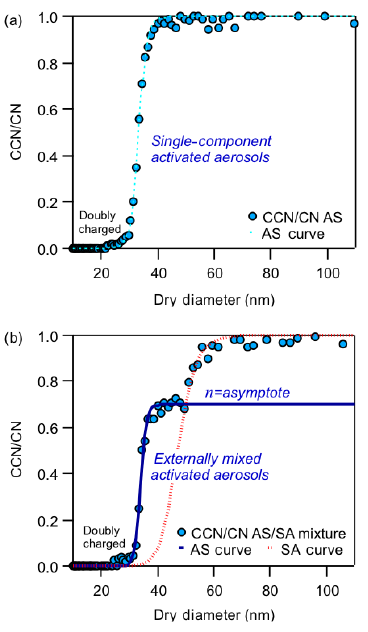
Figure 2. Example of a charge-corrected (a) single-component ac- tivation curve and (b) a multiple activation curve from an externally mixed/heterogeneous system. The asymptote, η , varies in height and length with the presence of mixed components and their re- spective